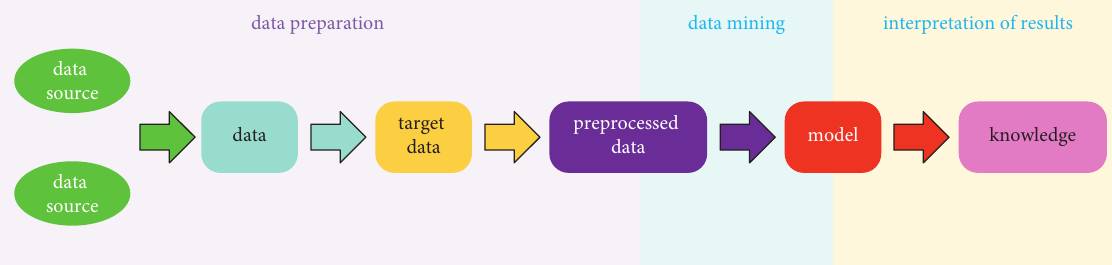
Figure 3: Data mining